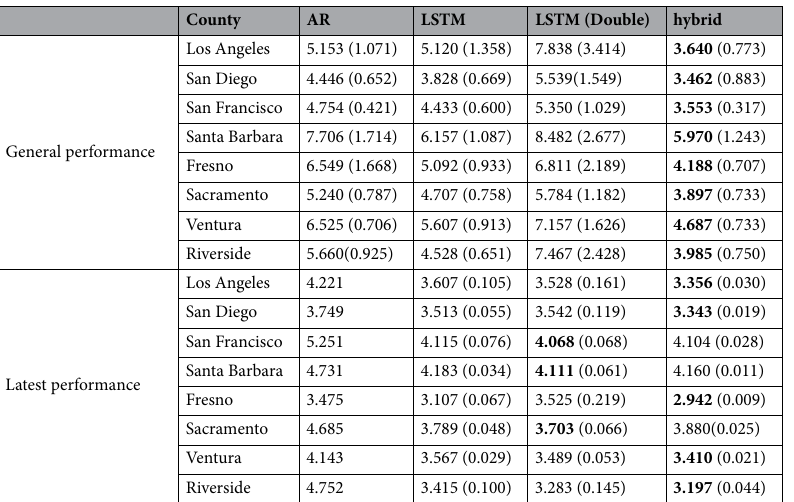
Table 2. MAPE (by percentage) for each model on each county. General performance is averaged on all trials. The inconsistent performances of neural networks have been compensated by the small step value, which is 7. The Latest performance is on the latest trial, from 2022-06-10 to 2022-09-05. The results for LSTM, LSTM double and hybrid are each averaged on 100 runs, to compensate the inconsistent performances of neural networks. The value in parenthesis is the standard error. AR has 0 or small standard error for the same trial. The hybrid model is usually the best in performance and has the lowest standard error. Best performances are given in